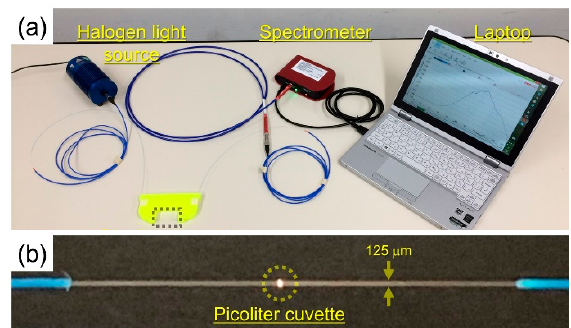
Figure 2. ( a ) Measurement configuration for acquisition of optical extinction spectra. The concentration of L-cysteine is measured with a simple configuration of a compact white light source, a compact spectrometer with a laptop for storing light intensity spectrum data, and the picoliter cuvette. ( b ) Enlarged picture of the picoliter cuvette inside the optical fiber, represented as a dotted square in ( a ). The optical fiber propagating light irradiated the cuvette, and the scattered light is placed in the photograph.